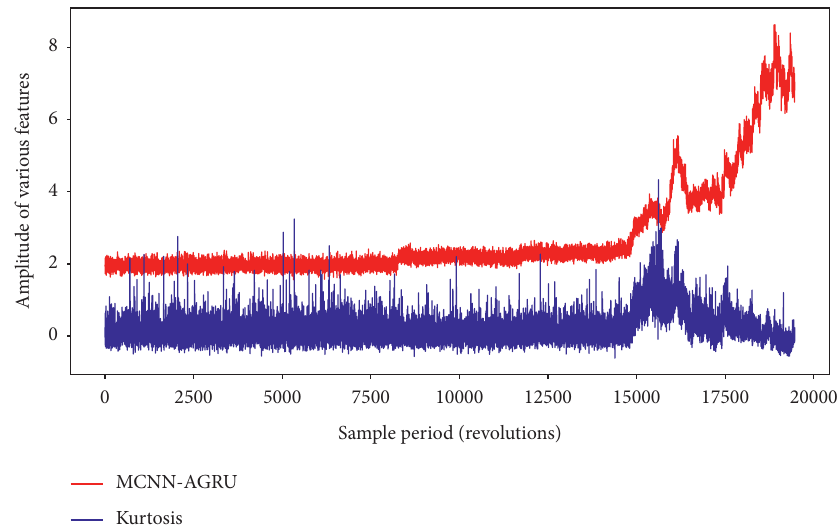
Figure 14: Comparison of MCNN-AGRU and Kurtosis.